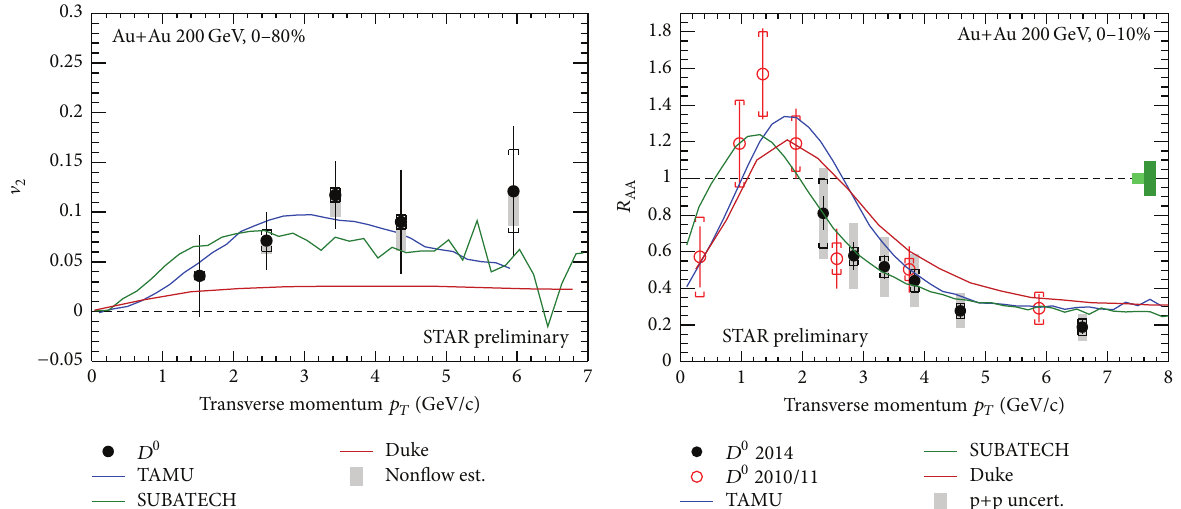
Figure 8: 𝐷 0 -mesons V 2 (0–80%) [32, 47] and 𝑅 AA (0–10%) [48] in Au+Au collisions at √ 𝑠 NN = 200 GeV and comparison with selected theoretical models [26, 38, 49].